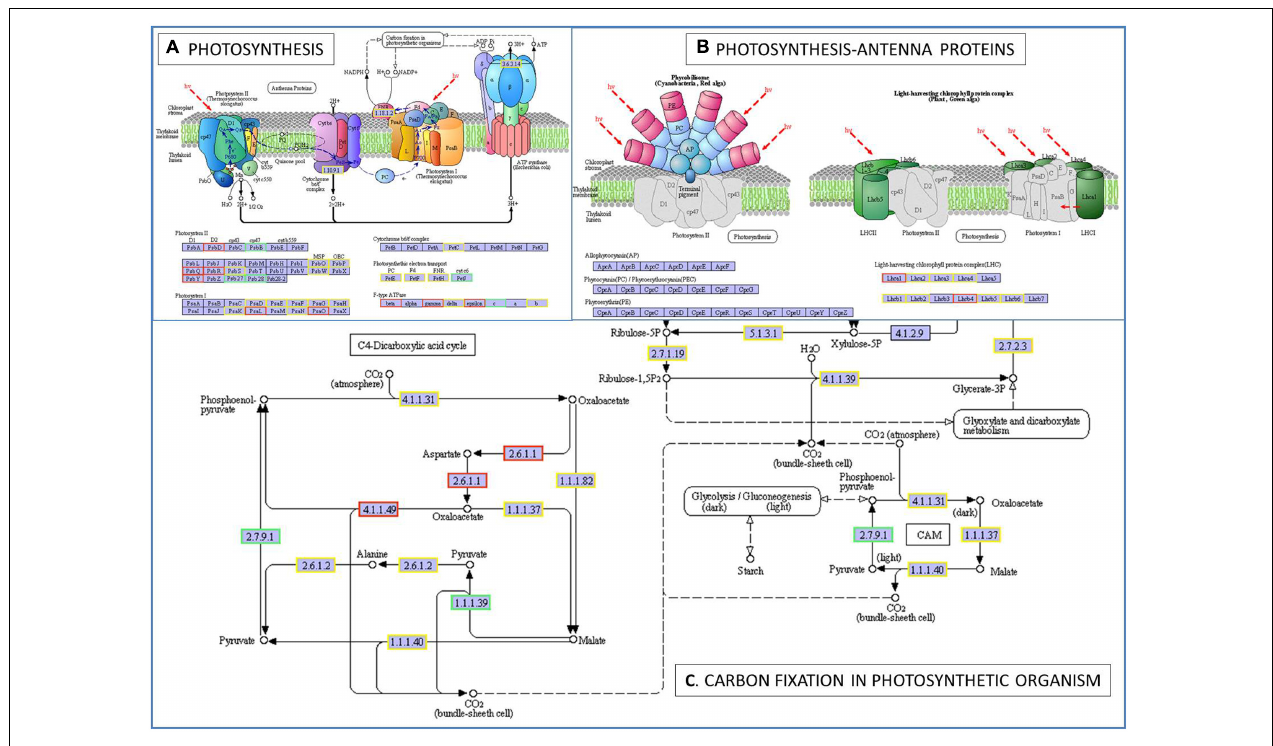
FIGURE 6 | The pathways of photosynthesis (A) , photosynthesis-antenna proteins (B) , and carbon fixation in photosynthetic organism (C) enriched by KEGG analysis. A gene/protein name in a red and blue box represent up-regulation and down-regulation under heat stress, respectively. PsbD, photosystem II P680 reaction center D2 protein (EC:1.10.3.9); PsbB, photosystem II CP47 chlorophyll apoprotein; PsbQ, photosystem II oxygen-evolving enhancer protein 3; PsbR, photosystem II 10 kDa protein; Psb27, photosystem II Psb27 protein; Psb28, photosystem II 13 kDa protein; PsaL, photosystem I subunit XI; PsaO, photosystem I subunit; petJ, cytochrome c6; Lhca1, light-harvesting complex I chlorophyll a/b binding protein 1; Lhcb4, light-harvesting complex II chlorophyll a/b binding protein 4; EC:2.6.1.1, aspartate aminotransferase, cytoplasmic; EC:4.1.1.49, phosphoenolpyruvate carboxykinase (ATP); EC:2.7.9.1, pyruvate, orthophosphate dikinase; EC:1.1.1.39, malate dehydrogenase